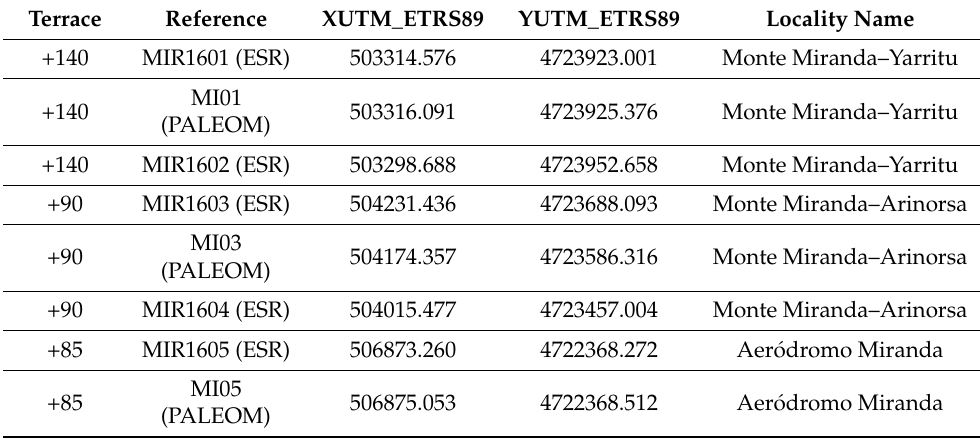
Table 1. Sample location and details of studied fluvial